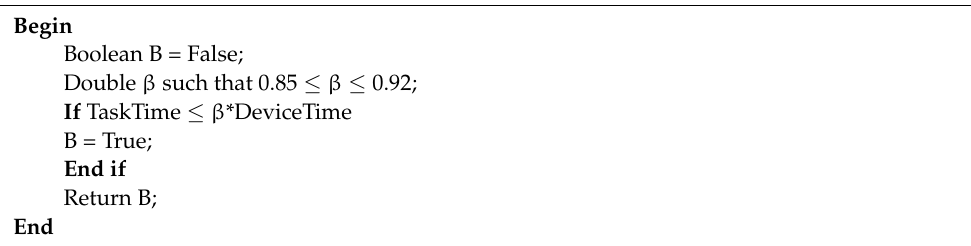
Algorithm 2 DeviceHasExecutionTime (TaskTime,